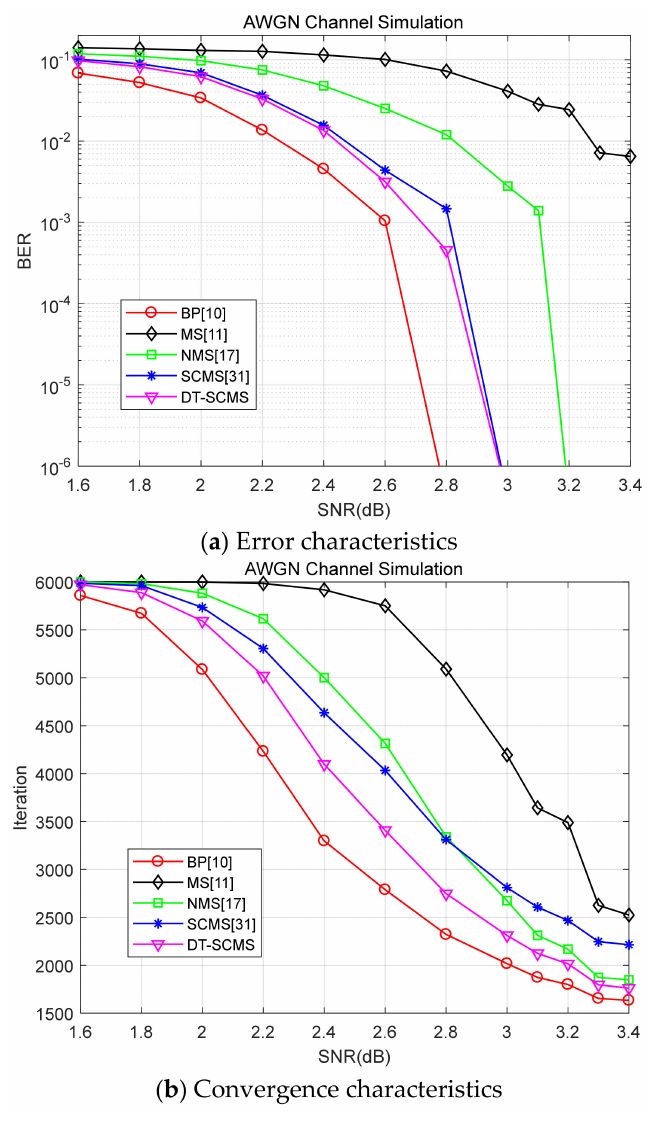
Figure 4. Simulations of BP, MS, NMS, SCMS, DT-SCMS, when R = 2 / 3.